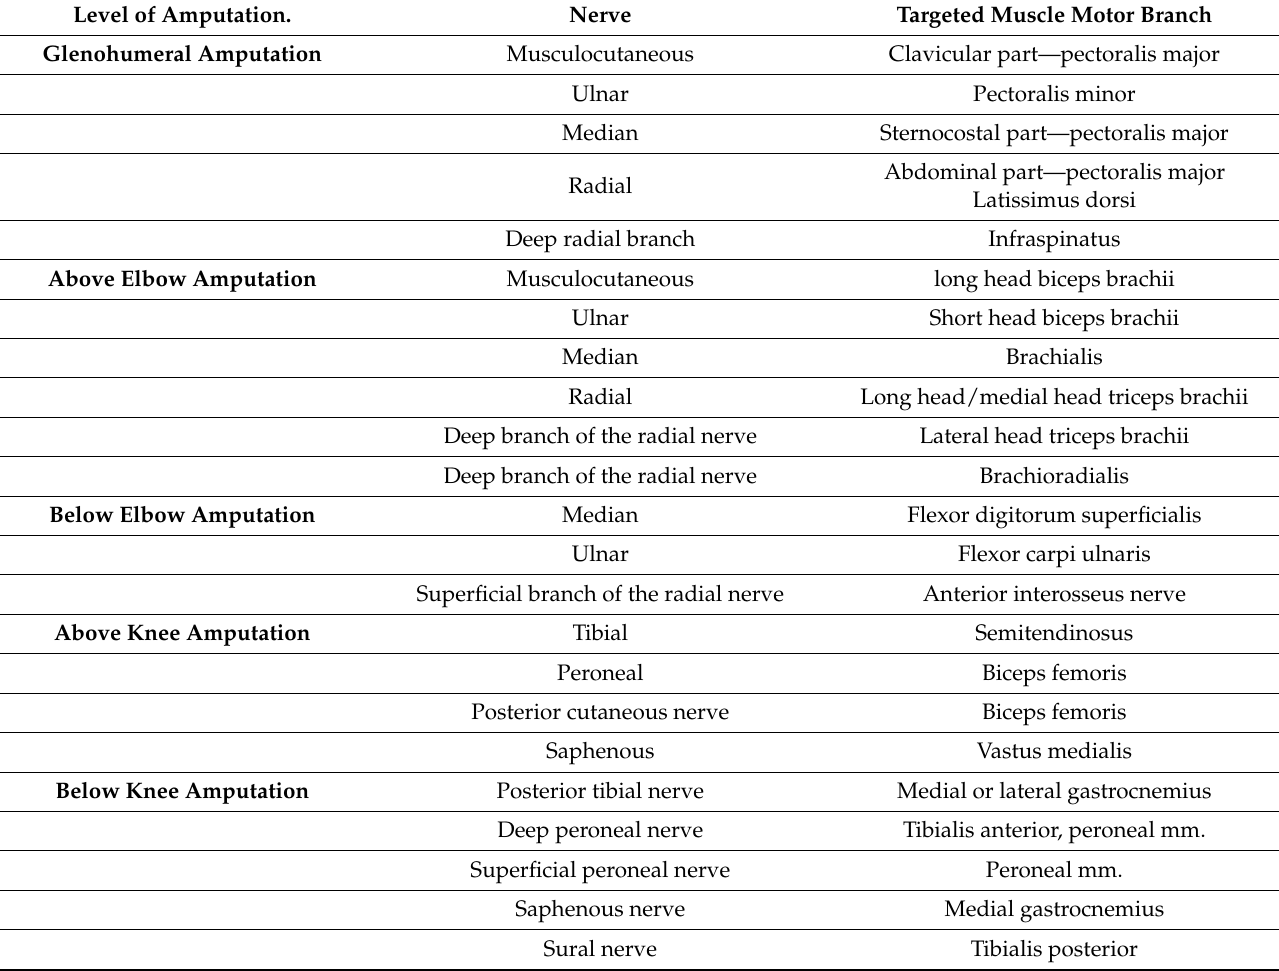
Table 1. TMR nerve transfer matrix according to different levels of amputation used in our facility. Note that individual planning is required according to definite level of amputation. The transfers were adapted from our experience from